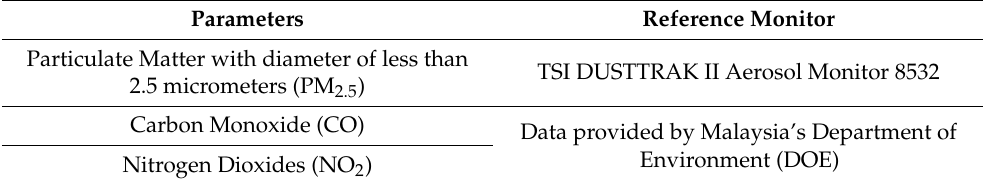
Table 1. Parameters and reference monitors used in the study.